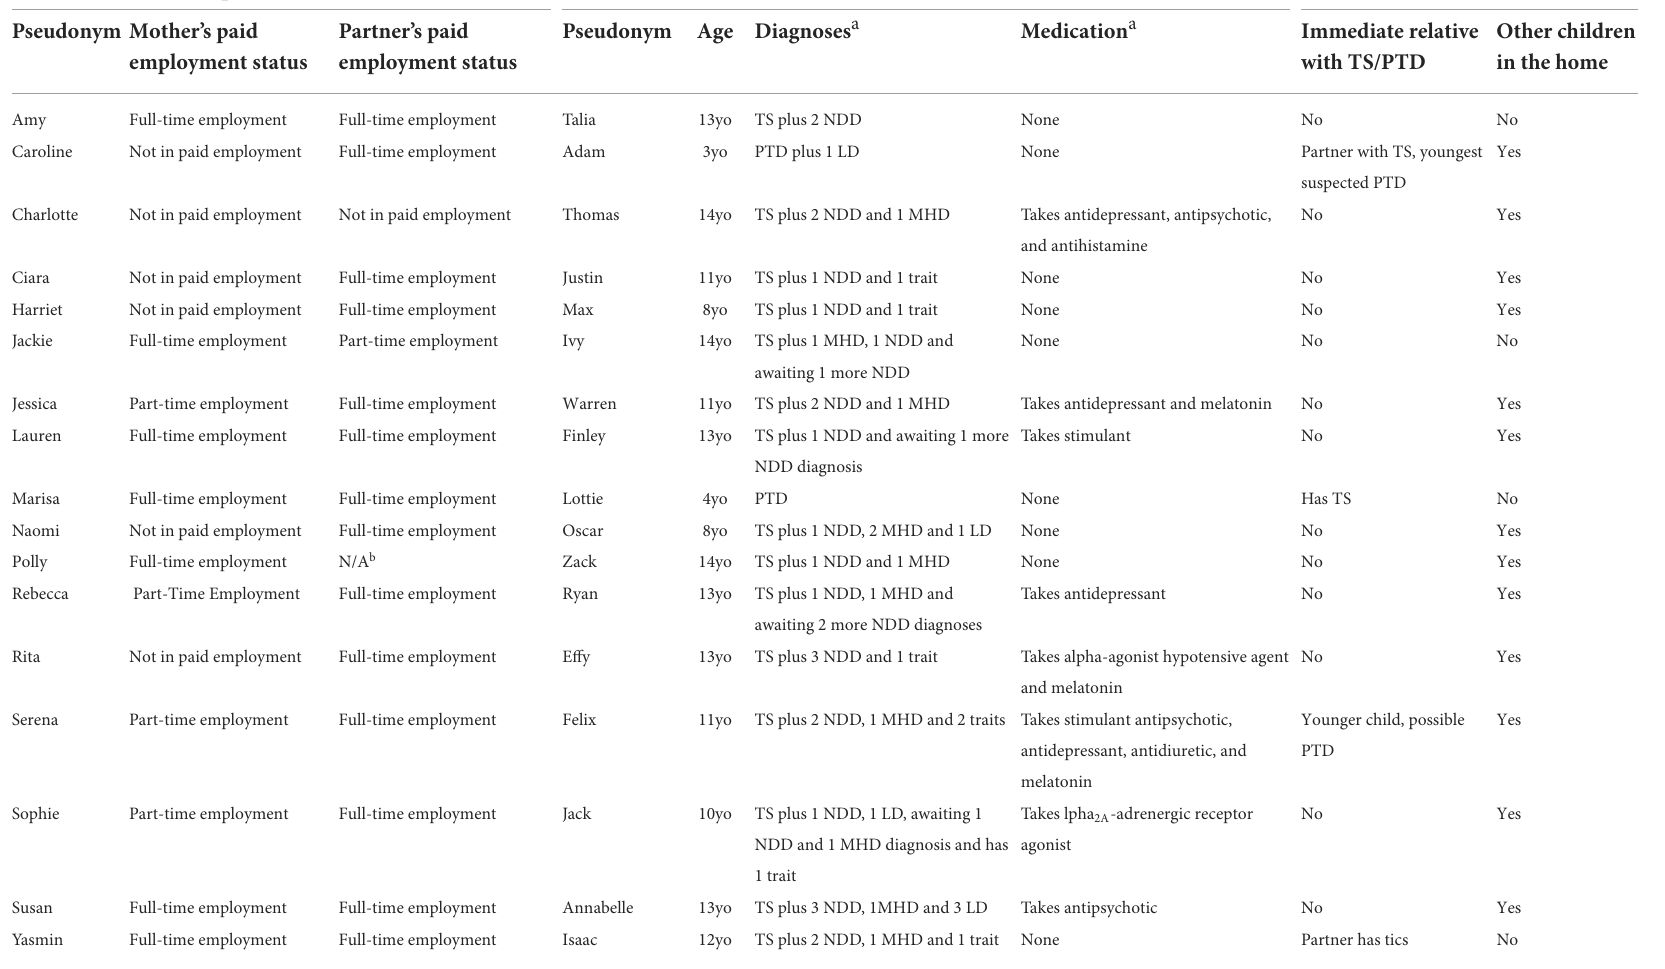
TABLE 1 Parent, child, and family